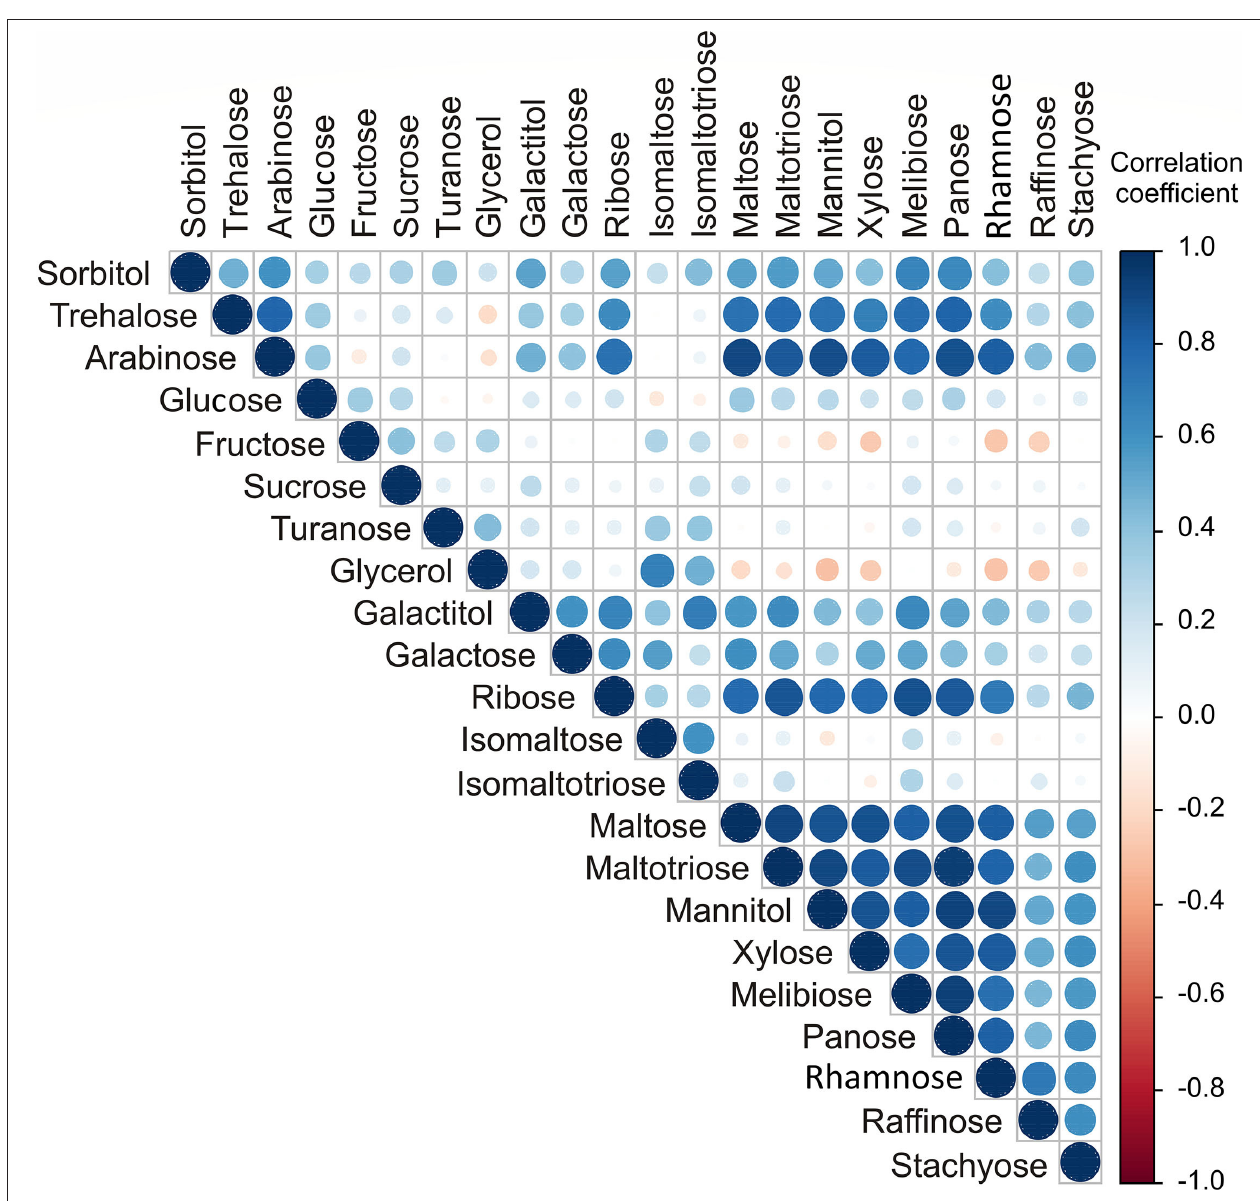
FIGURE 2 | Color correlation graph between sugar content in apple